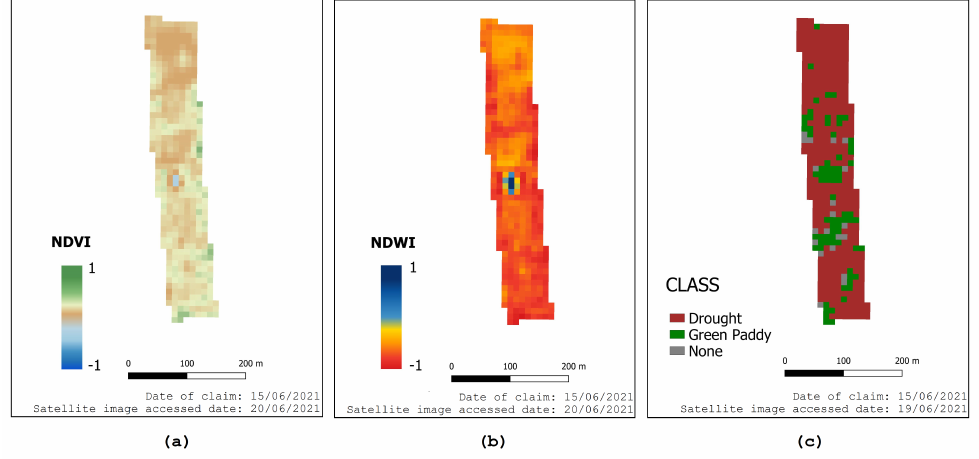
Figure 11. Predicted drought distribution in a sample flooded land plot using ( a ) the NDVI method on Sentinel-2A, ( b ) the NDWI method on Sentinel-2A and ( c ) the CART method on Sentinel-1 SAR